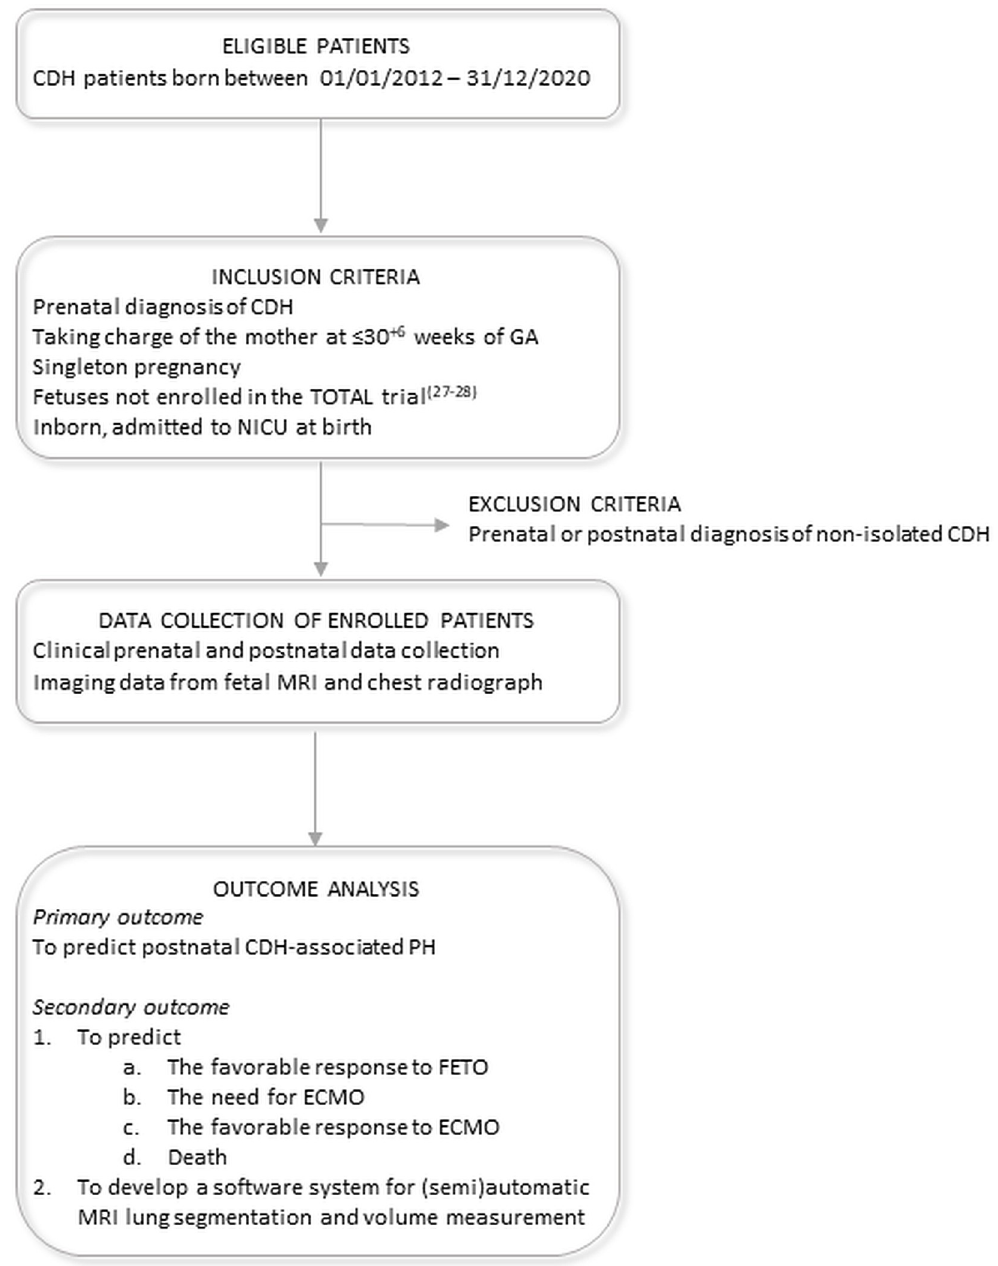
Fig 2. Study flow chart. CDH: Congenital diaphragmatic hernia; GA: Gestational age; NICU: Neonatal intensive care unit; MRI: Magnetic resonance imaging; PH: Pulmonary hypertension; FETO: Fetal endoscopic tracheal occlusion; ECMO: Extracorporeal membrane